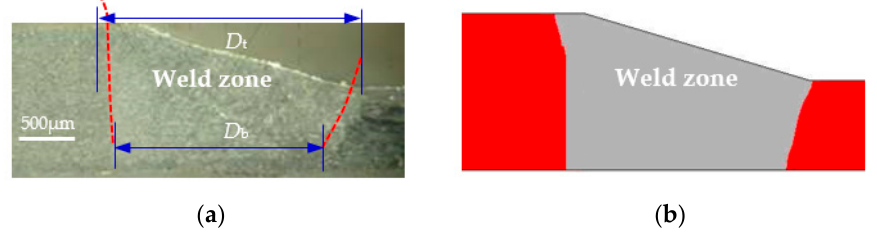
Figure 7. Comparison of weld cross-section: ( a ) Experimental result; ( b ) calculated result.